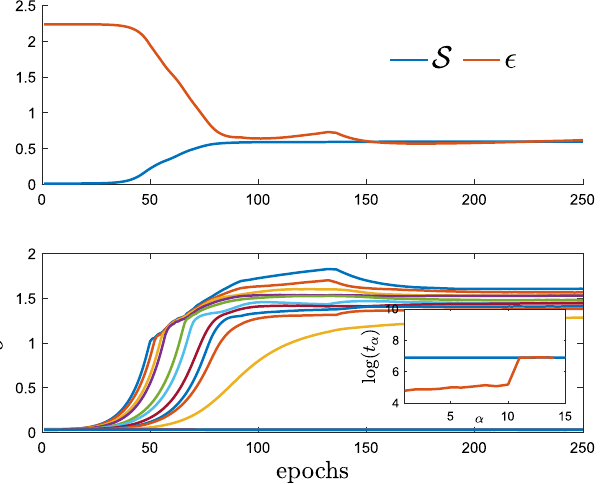
Figure 5. Upper panel: Pseudo-likelihood S and error ǫ for M during learning. Data is produced by a teacher 1000 , P 10 , M 1000 at β 2 . Learning is done with an RBM with N Hopfield model with N = = = = 15 hidden units. Lower Panel: emergence of singular values σ during learning for the visible units and N h = 10 modes emerge. Inset: error t α for different modes at the beginning of learning (blue line) same dataset. P = and at the end of learning (orange